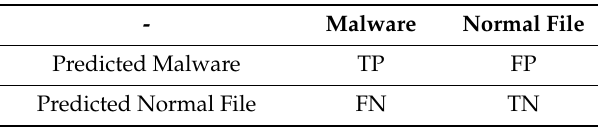
Table 2. Confusion